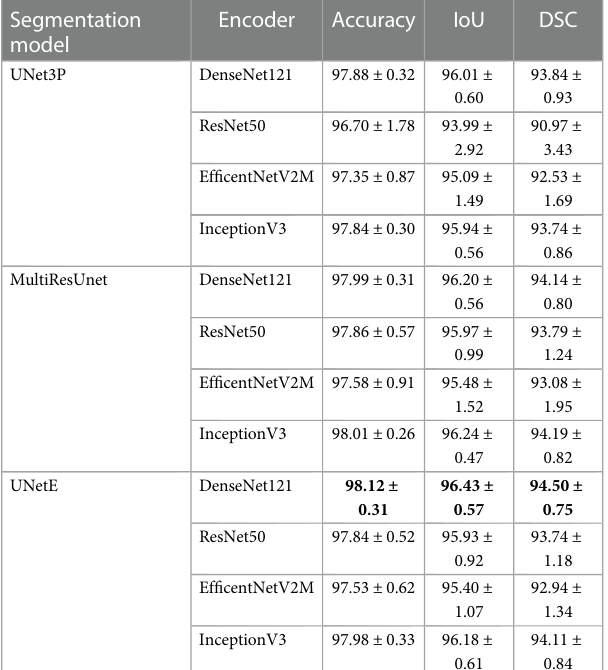
TABLE 2 Segmentation results including IoU (intersection over union) and DSC (dice similarity coef fi cient). Segmentation model